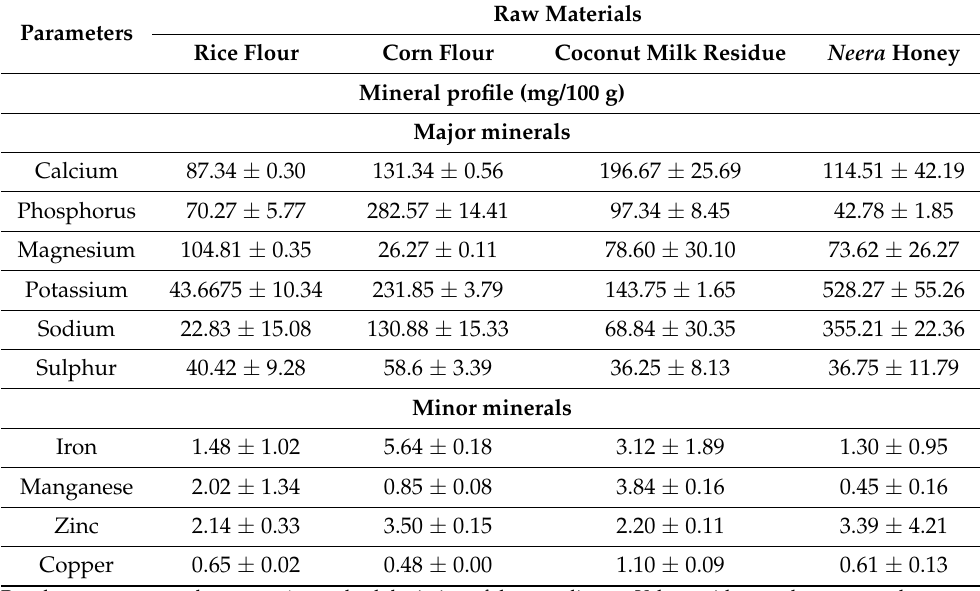
Table 4. Mineral profile of raw materials used for preparation of